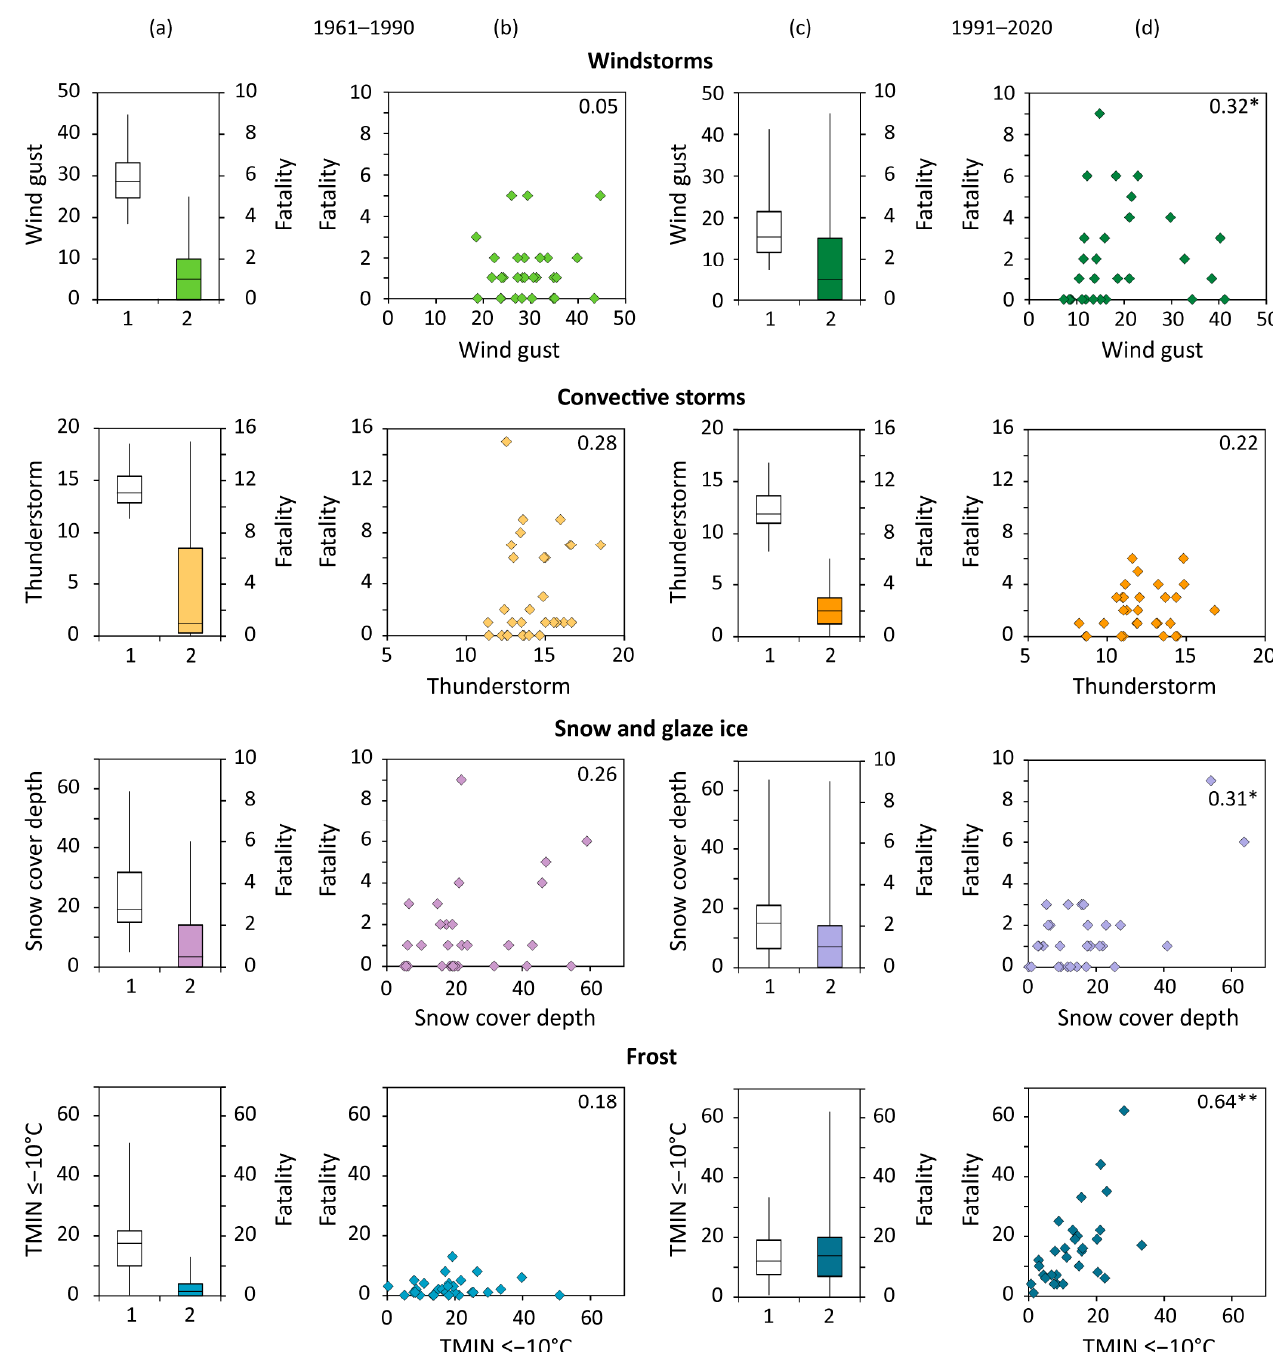
Figure 10. Comparison of selected climate variables (days with wind gust ≥ 20 m s − 1 , thunderstorm, snow cover depth ≥ 15 cm, TMIN ≤ − 10.0 ◦ C) with weather-related fatalities (windstorms, convective storms, snow and glaze ice, frost) in the Czech Republic during the 1961–1990 ( a , b ) and 1991–2020 ( c , d ) periods, expressed as box plots (median, upper and lower quartile, maximum and minimum; 1—climate variable, 2—fatalities) ( a , c ) and scatter-plots between corresponding pairs ( b , d ). Values of Spearman correlation coefficients are in the top right (* significant for p < 0.10, ** for p < 0.05).